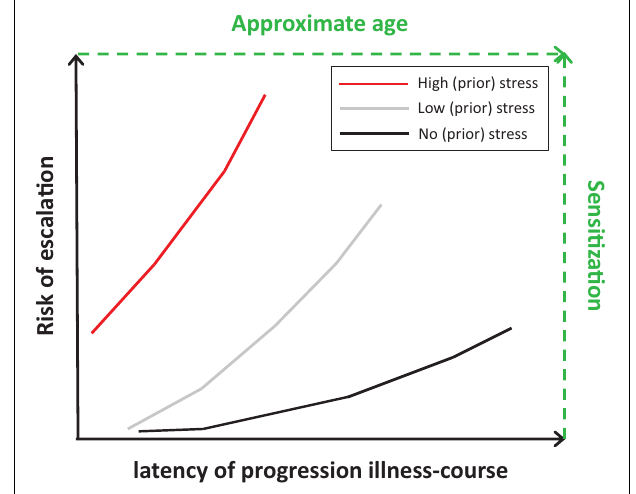
FIGURE 5 | Hypothesized relationships between no stress (black line), low stress (gray line), and high stress (red line) on risk and latency of escalation . High stress relates to early onset and increased risk of (rapid) escalation to a substance use disorder (early onset and steeper risk-latency slope), whereas no stress relates to later onset and low risk to transition to problematic substance use or to a substance use disorder (later onset and shallow risk-latency slope). Effects of stress on risk and latency may follow those on level of sensitization of motivational systems and age of people (text in